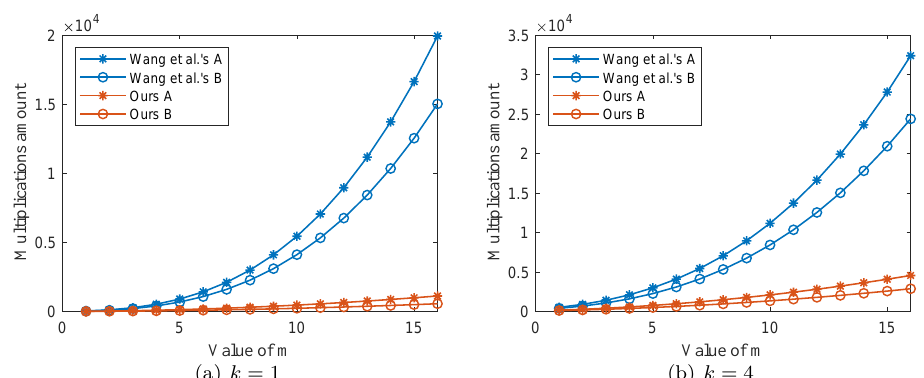
Figure 1: Comparison of the number of multiplications with increasing m for the original masked gadgets and our improved ones.